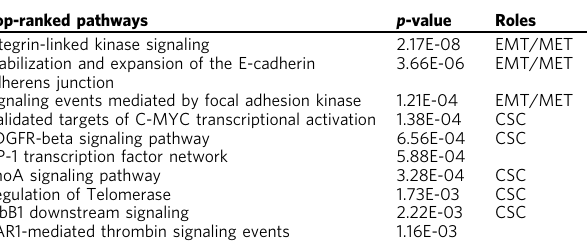
Table 1 Pathways distinguishing the HER2 + MET-like and HER2 − EMT-like CTCs. The p -value was determined by Fisher ’ s Exact Test Top-ranked pathways p -value